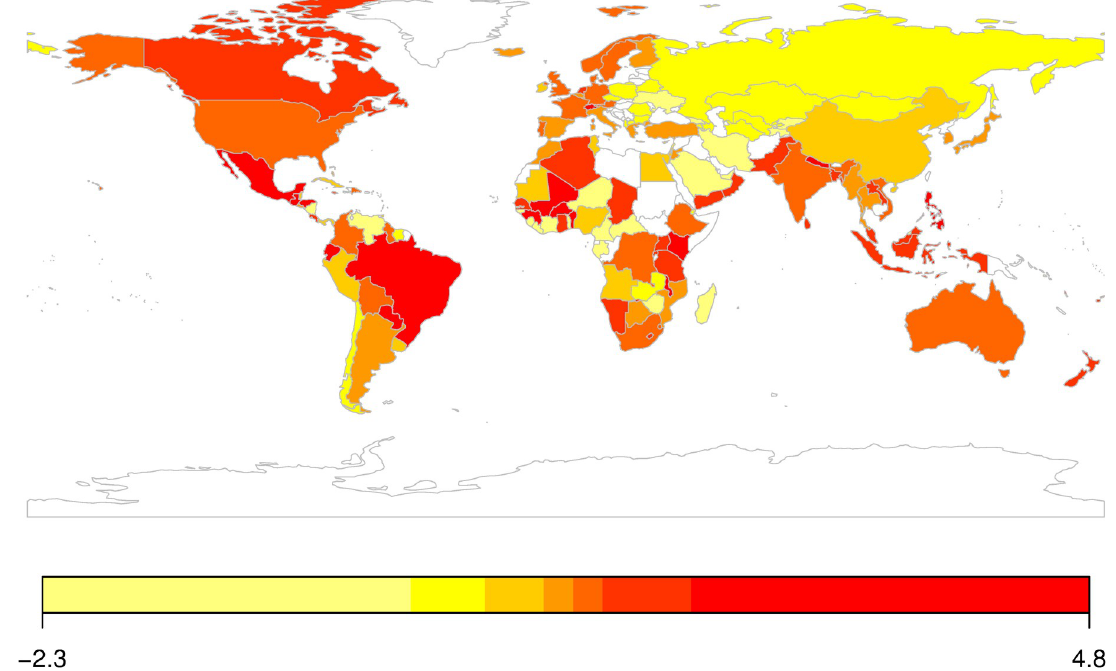
Fig 3. Distribution of estimated income elasticities of adult obesity prevalence across 147 countries. Income elasticities in countries are represented by color scales. The map was created using Rworldmap package in R [38].